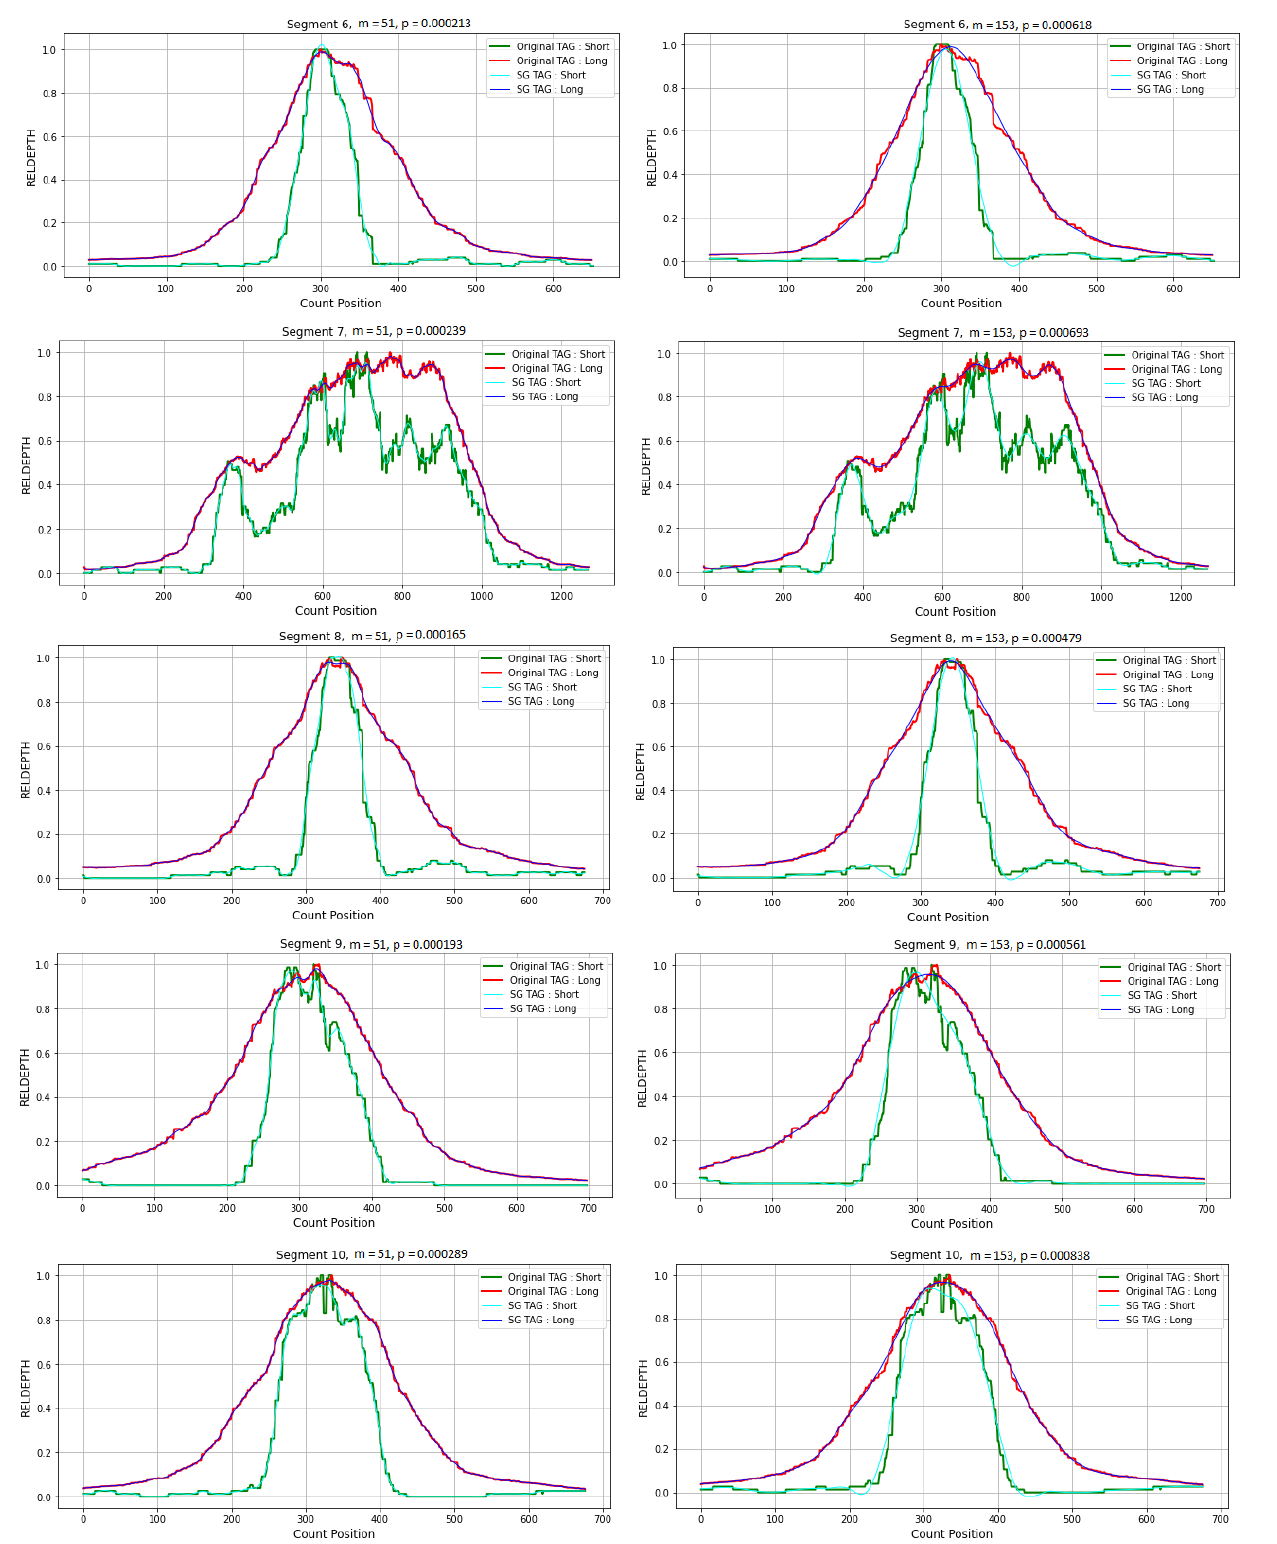
Figure A3. Show Adaptive Savitzky–Golay filtering of CNV peaks for segment 6 to 10 before and after correction. Green and red solid line are the original short and long tag CNV peaks , respectively; cyan and blue solid lines are the smoothed the short and long tags CNV peaks,